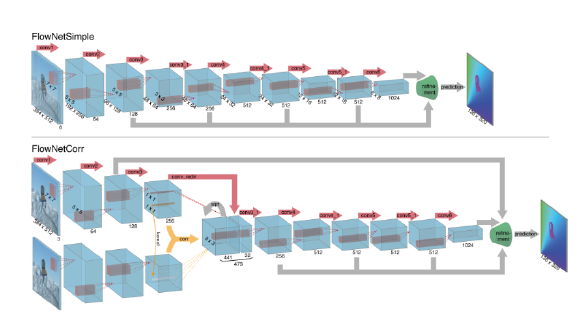
Figure 4. FlowNet architectures (Dosovitskiy et al.,